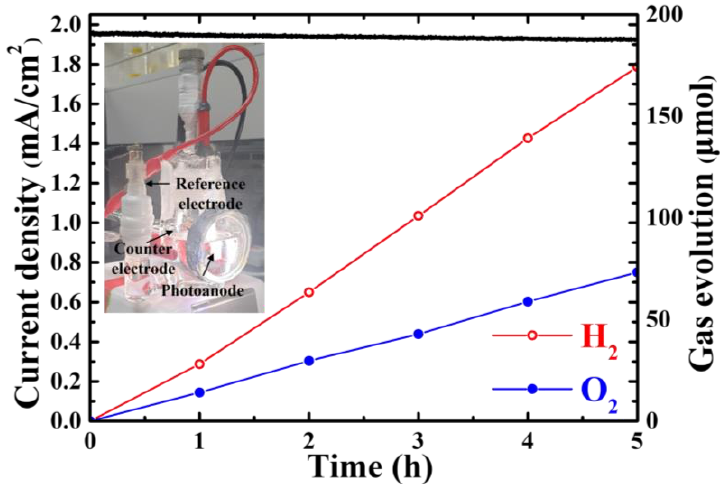
Figure 5. ( a ) FIB-low magnification TEM image, ( b , b-1 ) high resolution-TEM image (Inset: corre- sponding selected area electron diffraction (SAED)), ( c ) HAADF−STEM image, and EDS elemental mapping images of ( d ) Fe, ( e ) O, ( f ) Zr, ( g ) Sn, and ( h ) Al elements of the optimized 2:Al-Zr/HT photoanode.